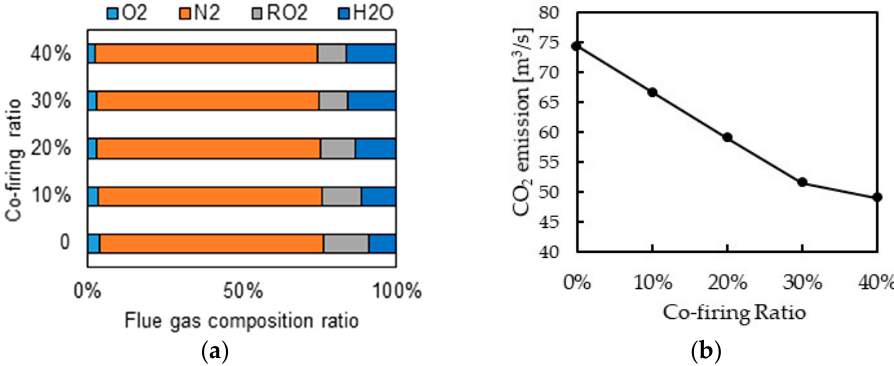
Figure 3. Flue gas composition ( a ) and CO 2 emission ( b ) varying with ammonia co-firing ratio.